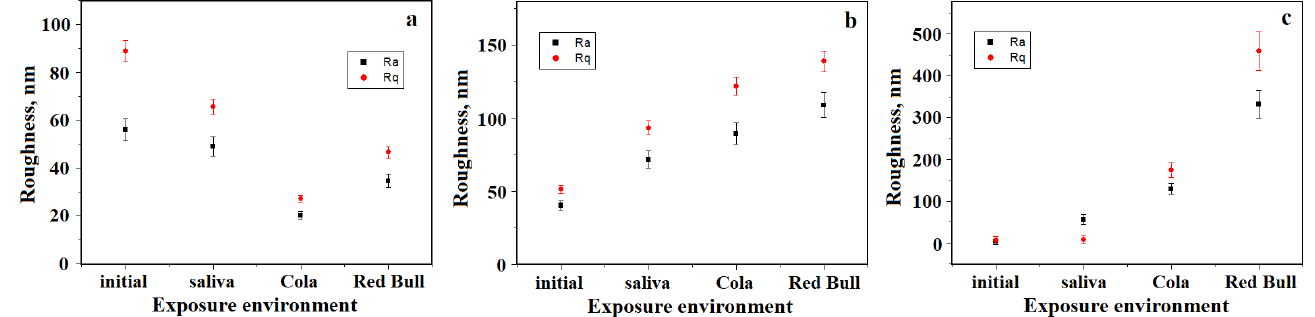
Figure 6. Roughness evolution after acidic environment exposure for the tested orthodontic cements: ( a ) BracePaste, ( b ) Fuji Ortho and ( c ) Transbond.